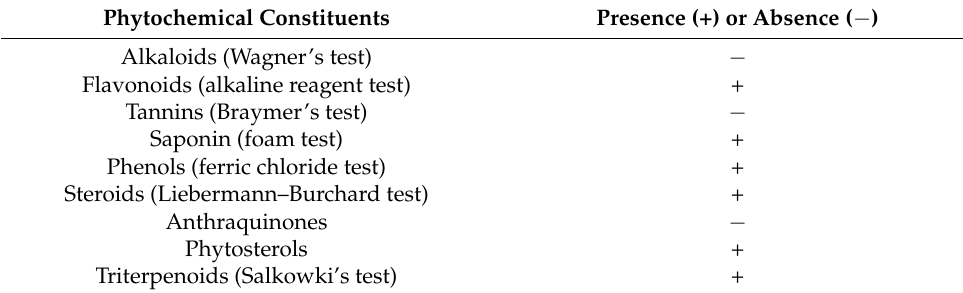
Table 1. Phytochemical constituents of leaf extract of F. lepicarpa . Phytochemical Constituents Presence (+) or Absence ( − ) Alkaloids (Wagner’s test) − Flavonoids (alkaline reagent test) + Tannins (Braymer’s test) − Saponin (foam test) + Phenols (ferric chloride test) + Steroids (Liebermann–Burchard test) + Anthraquinones − Phytosterols + Triterpenoids (Salkowki’s test) +